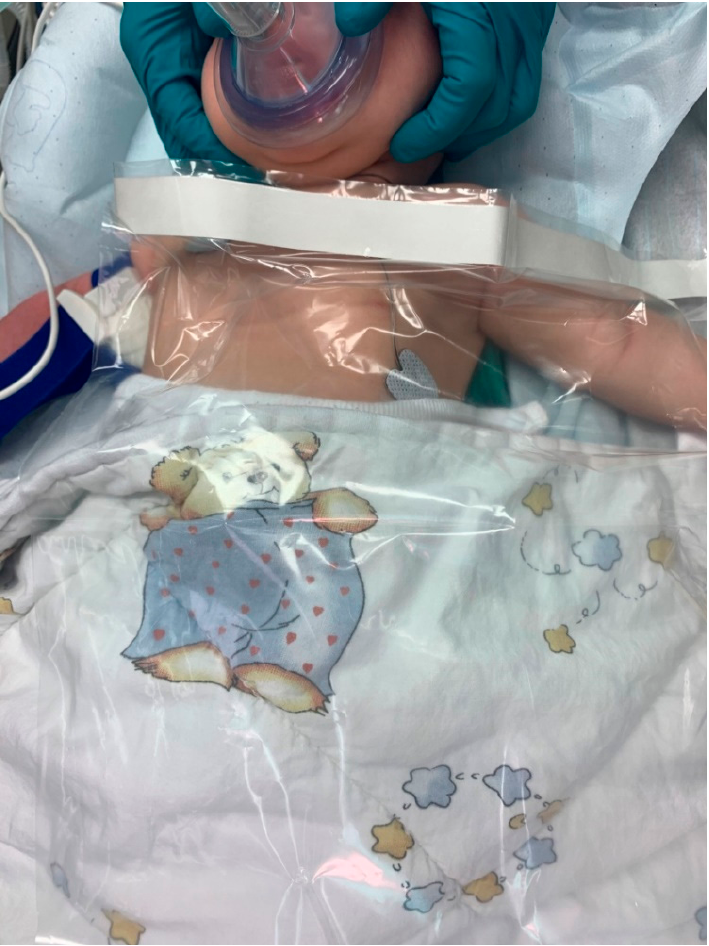
Figure 4. Continued warming therapy after mask-induction during IV-cannulation of an infant.